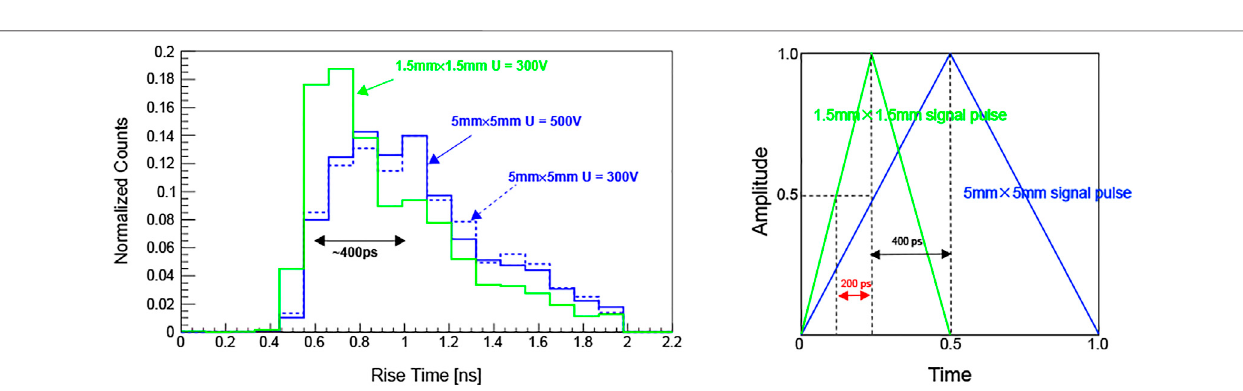
FIGURE 10 | Qualitative explanation of the origin of the shifts of the mean of Δ T . The left fi gure shows the distribution of signal rising time for different size devices. The right fi gure indicates that a faster rising time leads to a smaller ToT (time over threshold), so the mean of Δ T is shifted.